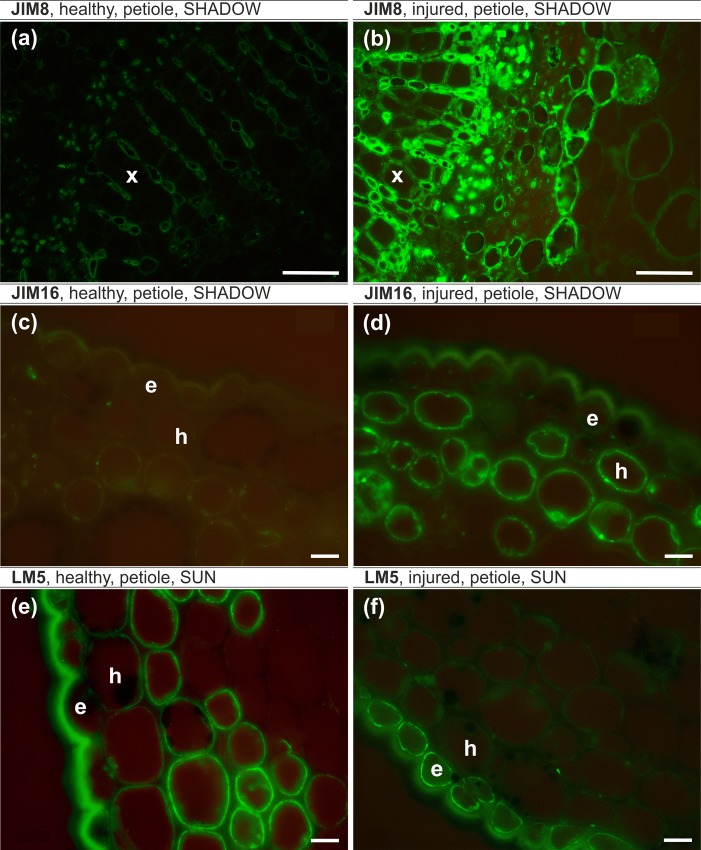
JIM8 epitope, petiole, shady side (a,b), JIM16 epitope, petiole, shady side (c,d), LM5 epitope, petiole, sunlit side (e,f). (a,c,e) – healthy leaf, (b,d,f) – injured leaf. e – epidermal cells, h – hypodermal cells, x – xylem cells. Bars (a,b), 50 μm; (c-f), 10 μm.